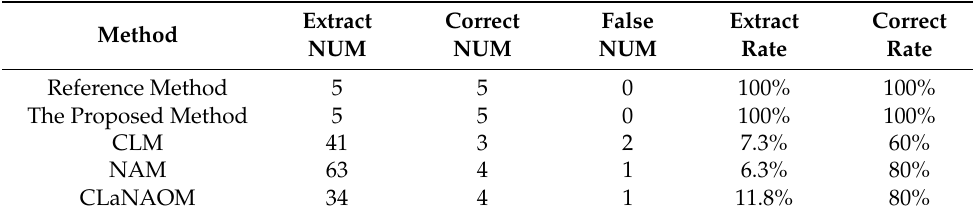
Table 10. The mountain vertices extraction results for each method using the third dataset.